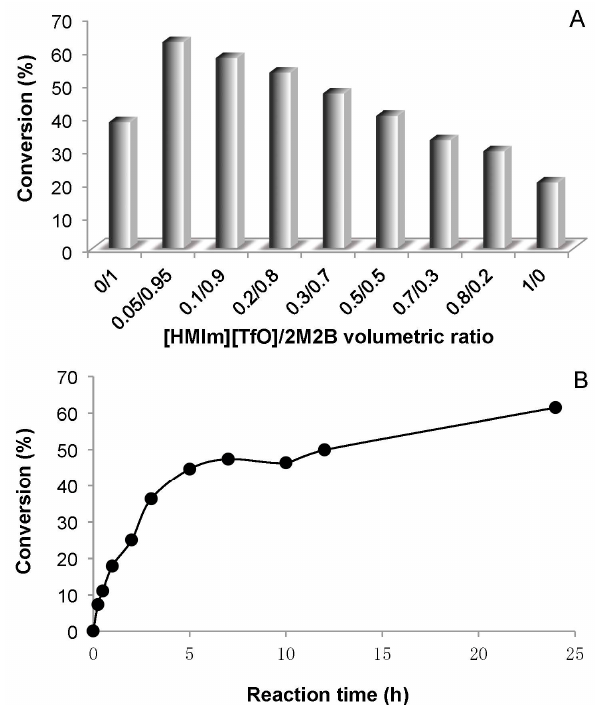
Figure 3. Novozym 435-catalyzed esterification of methyl glucoside and palmitic acid in the [HMIm][TfO]/2M2B bisolvent system. ( A ) Effect of IL/2M2B volumetric ratio on the conversions obtained in 21 h; ( B ) Time course of the reaction under optimal conditions: 0.3 M of methyl glucoside and palmitic acid, 150 mg of molecular sieve, 10 mg of Novozym 435, and 1.0 mL of solvent ([HMIm][TfO]/2M2B, 0.05:0.95, v/v ) at 45 °C.